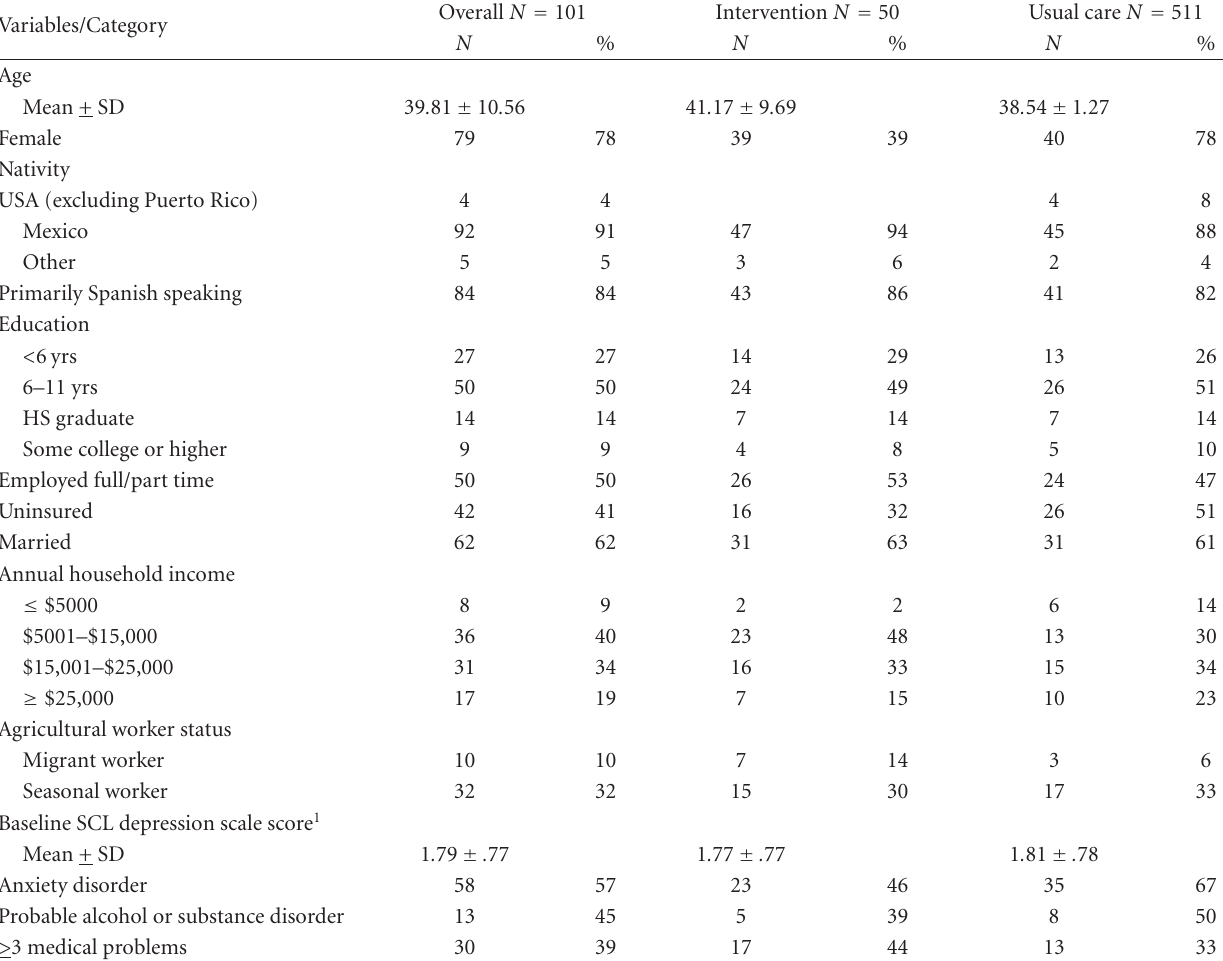
Table 1: Characteristics at baseline of 101 patients who received telephone-based CBT or enhanced usual care.